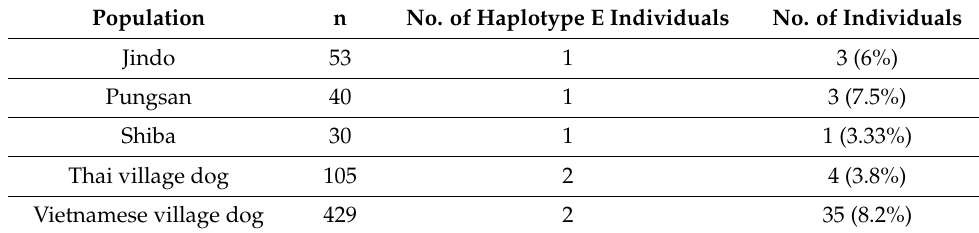
Table 3. Haplotype and nucleotide diversity of haplotype E in examined dog populations.